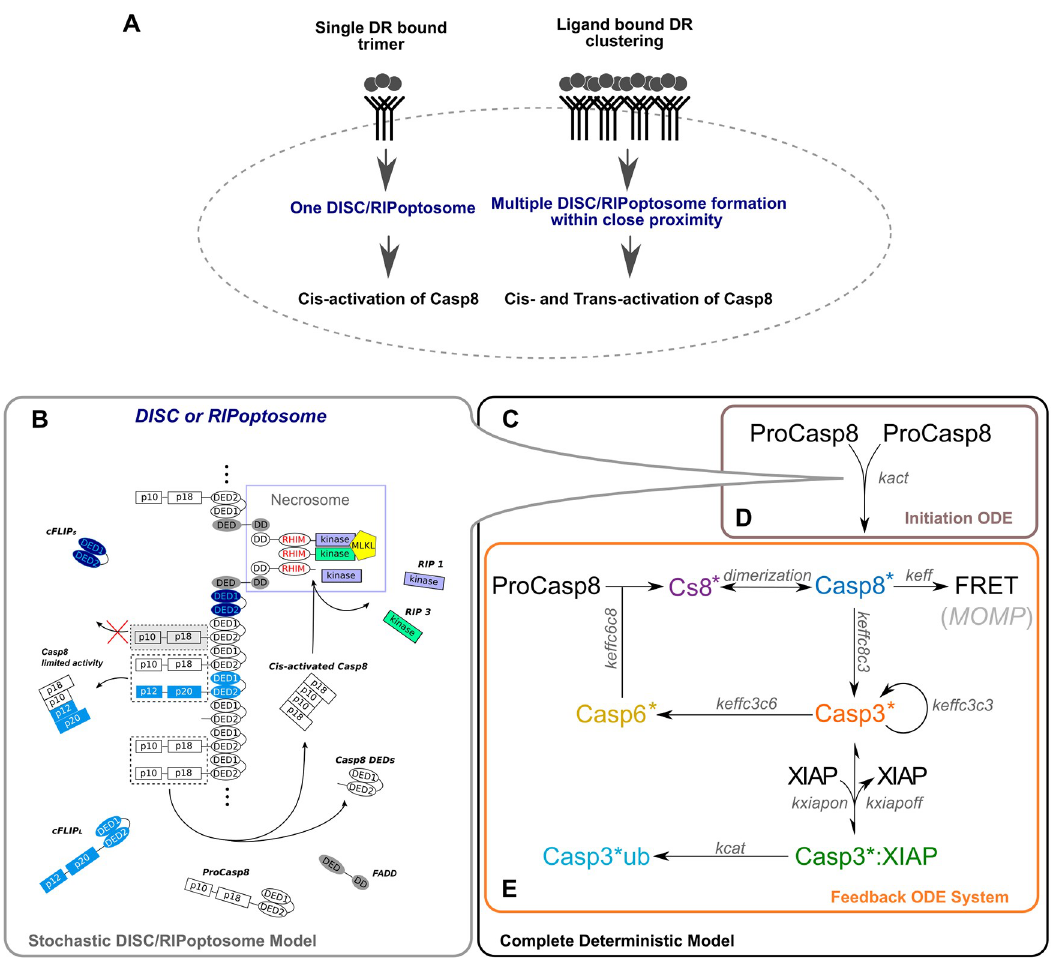
Fig 2. New modelling approach developed in this study to explain vulnerable dynamics of Casp8 activation and fractional cell death upon DR stimulation. (A) The DR clustering initiates the formation of a few RIPoptosomes in the closed proximity to each other where Casp8, in addition to cis-activation, can undergo trans-activation. (B) The initial stochastic Casp8 activation on the DISC/RIPoptosome platform is implemented by direct Gillespie stochastic simulation algorithm (SSA) which incorporates the molecular assembly of FADD, RIP1, RIP3, ProCasp8, cFLIPs/l proteins. (C) Complete deterministic system comprised of initiation ODE system (D) and feedback ODE system (E) used in the parameter scan and manual parameter adjustment. (D) Box represents the deterministic approximation of the population kinetics of Casp8 activation on the DISC/RIPoptosome platform. (E) Box represents the deterministic activation of the effector caspases, Casp3 and Casp6, which feedback to the rate of Casp8 activation before